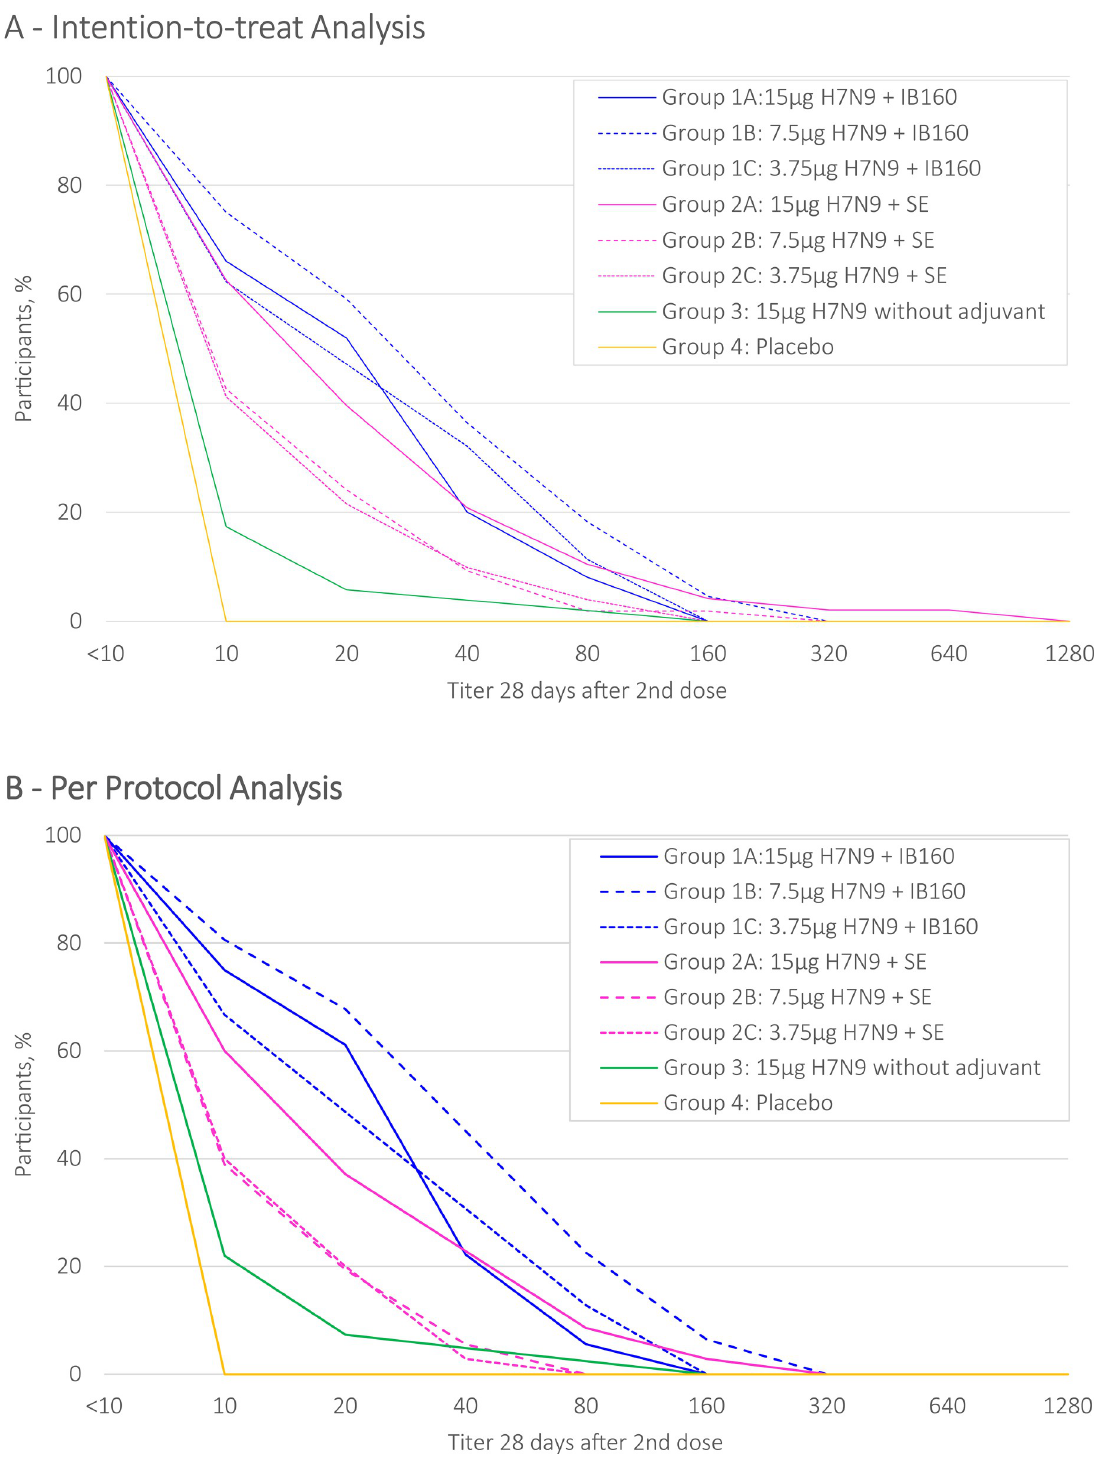
Fig 2. HI antibody against H7N9 reverse cumulative distribution curve after 28(+7) days post 2nd dose administration, intention- to-treat.